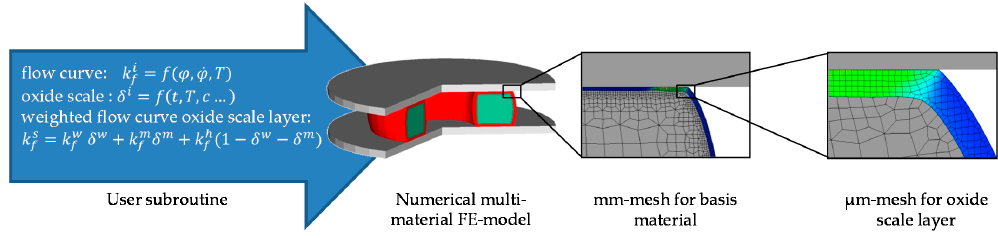
Figure 3. Schematic representation of the numerical model for thin surface layers and user subroutine.